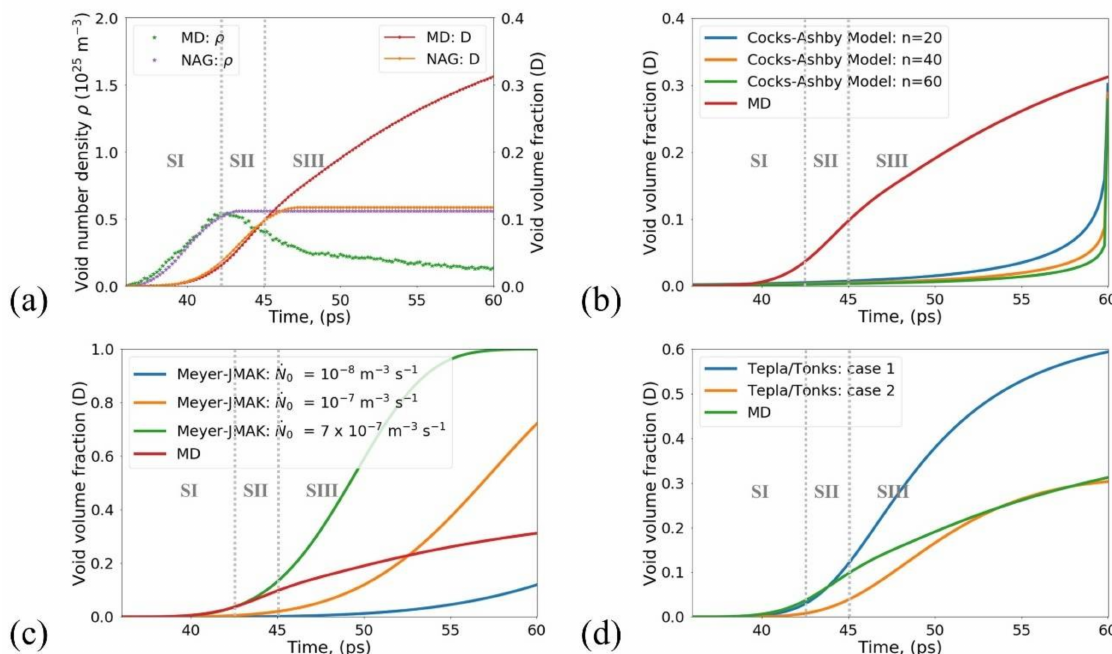
Figure 6. Damage evolution based on ( a ) the NAG model, ( b ) the Cocks–Ashby model with different choices of the parameter n, ( c ) the Meyer–JMAK treatment with different choices of the parameter compared to the MD results for (001) single-crystal Ta. The three distinct stages SI, SII, and SIII are marked with dashed